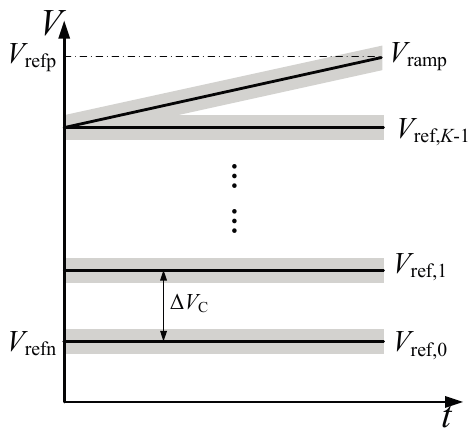
Figure 4. The ramp voltage and K reference voltages in practice.